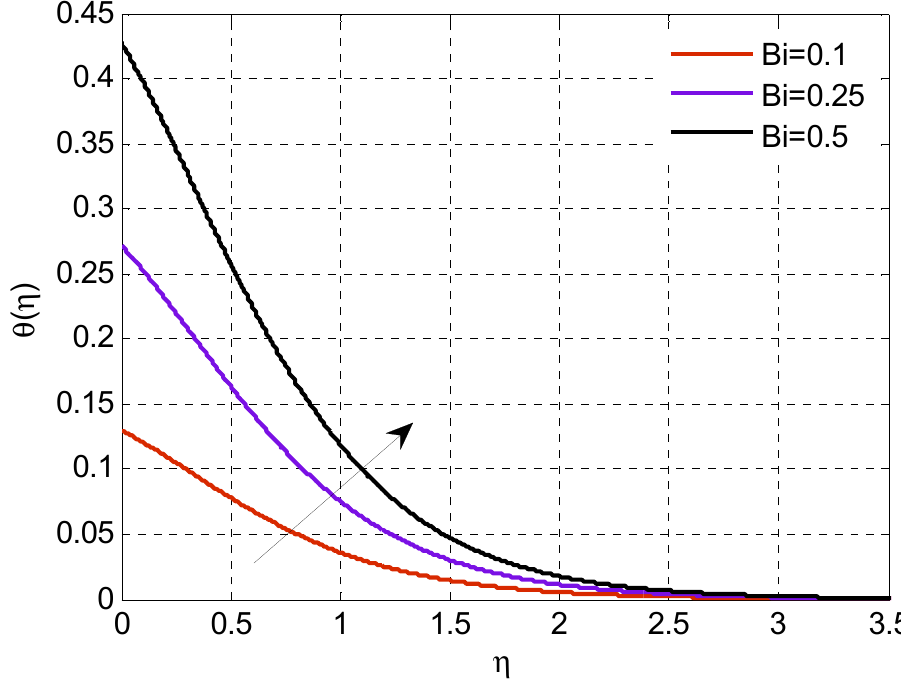
Figure 10. Effect of Biot number on temperature profile using G = 1, K b = 1, λ = 0.5, F r = 0.1, P r = 4, R d = 0.1, Q = 0.3, and N = 0.4